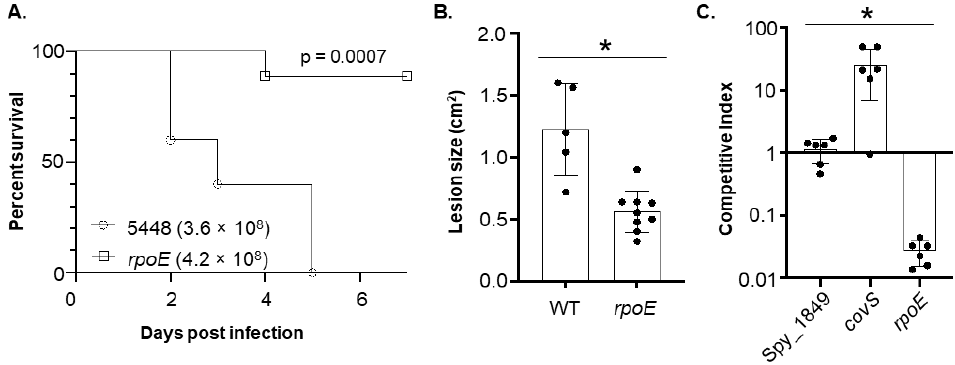
Figure 1. Mutation of rpoE in 5448 results in attenuation and loss of fitness in a murine soft-tissue infection model. ( A ) Disseminated systemic lethality was monitored following subcutaneous infection with wild type (WT, n = 5) 5448 or the rpoE mutant ( rpoE , n = 9) at the CFU doses indicated. The p value indicates statistical significance in lethality between the rpoE mutant and WT. ( B ) A separate experiment was done to measure ulcerative lesion size following subcutaneous infection after 48 h post-inoculation (pi). ( C ) Competition assays of a Spy_1849 mutant, a covS mutant ( covS ) and a rpoE mutant each co-infected with an equivalent inoculum of WT 5448 in the mouse model. The control data for Spy_1849 and covS were published [28] whereas the rpoE mutant was assayed in the same experiment but not previously published. CFU was harvested 48 h p.i. and quantified by plate dilution. Asterisk indicates statistical significance ( p ≤ 0.05) compared to WT ( B ) and each strain ( C ) using an unpaired t -test.